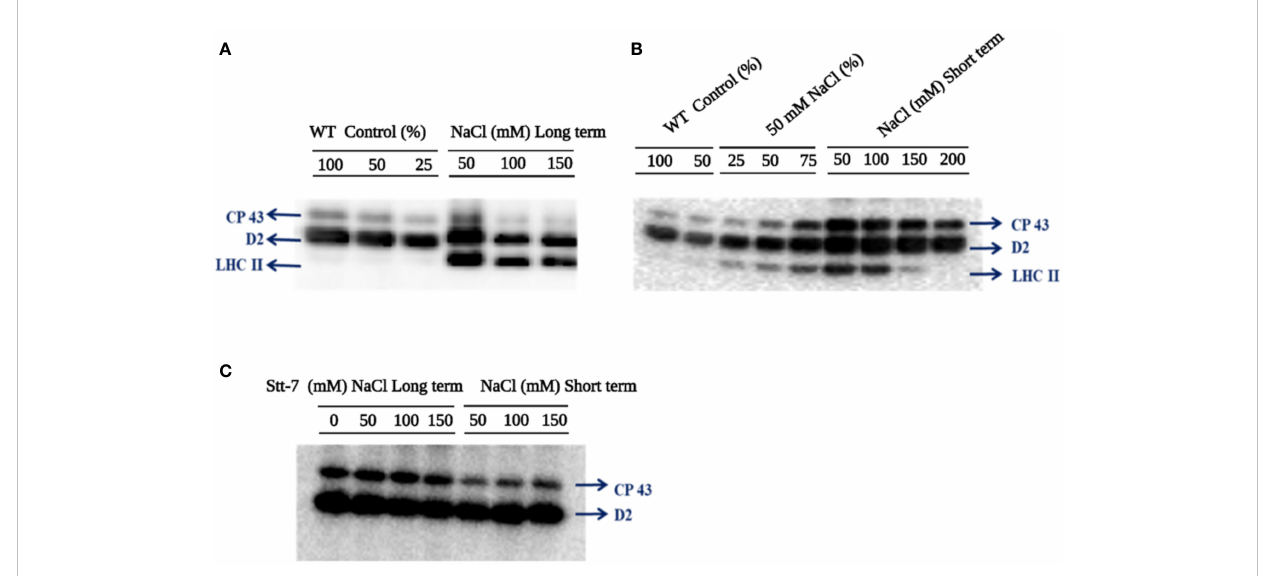
FIGURE 6 Immunoblotting analysis of thylakoid membranes probed with anti-phosphothreonine antibody (A) C. reinhardtii WT cells grown in various sodium chloride (NaCl) concentrations (0, 50, 100, and 150 mM for 96 hours (long-term). (B) C. reinhardtii WT control cells from the mid-log phase were treated with different NaCl concentrations (0, 50, 100, 150, and 200 mM) for 20 min (short-term). (C) C. reinhardtii stt7 cells were grown in long- term (96 h) and short-term (20 min) conditions with the indicated NaCl concentrations. In order to compare the loading control, the wild-type samples were loaded with different dilutions (25, 50, and